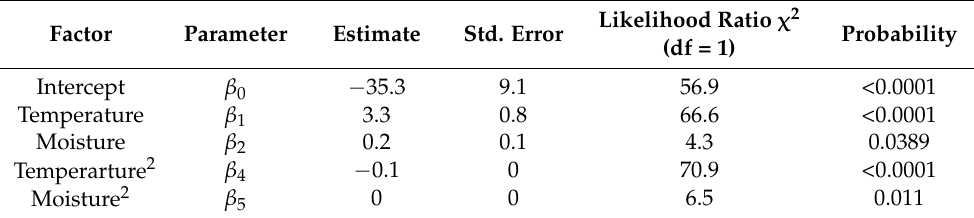
Table 3. Parameter estimates of the effects of temperature and soil moisture on CFU yield per gram of M. brunneum strain EAMa 01/58-Su microsclerotia.